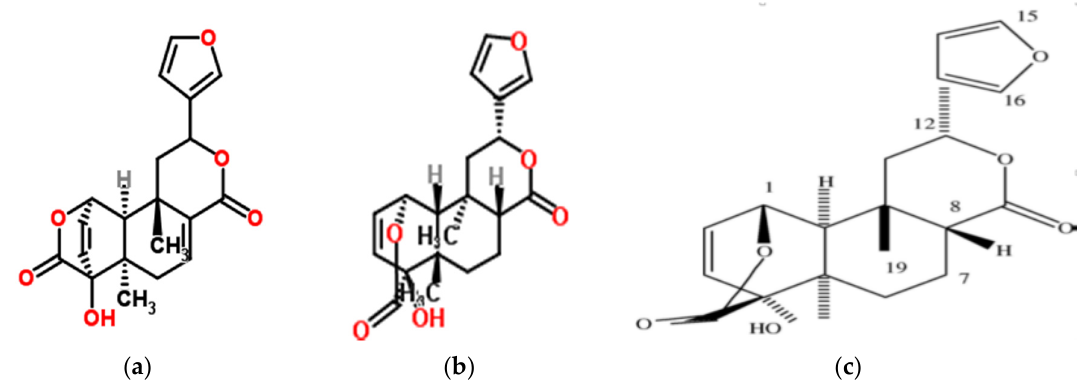
Figure 4. Isolated compounds from fruits of S. jollyanum . Structure of isolated fibleucin ( a ) and